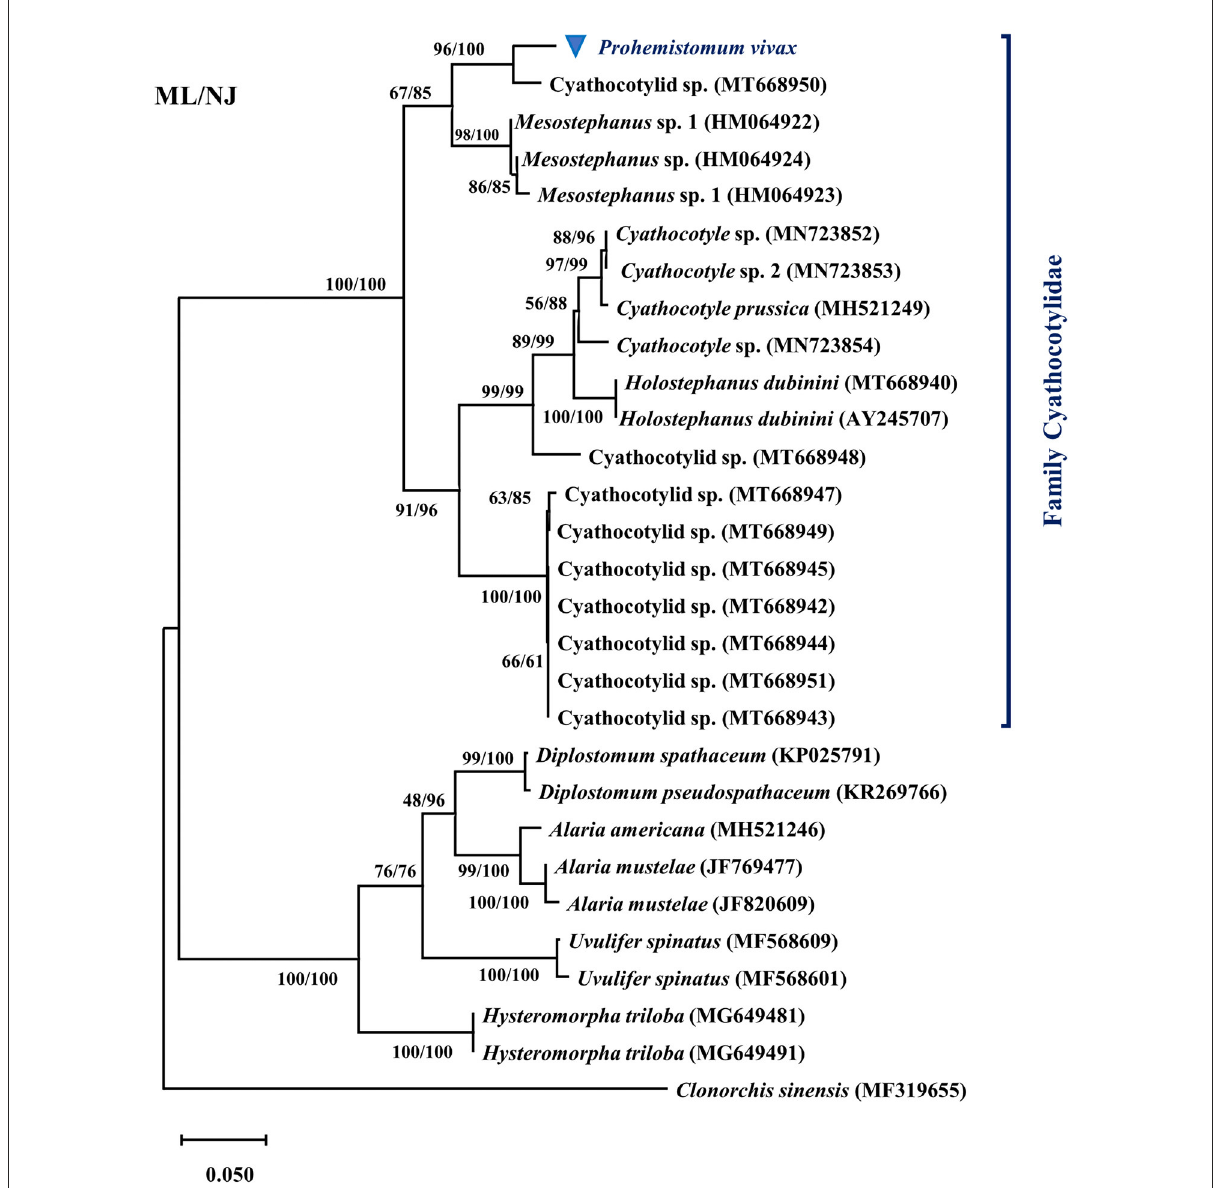
FIGURE3 Phylogenetic tree based on the ITS1-5.8S-ITS2 region of Prohemistomum vivax and other Diplostomata by the maximal likelihood (ML) and neighbor-joining (NJ) methods.